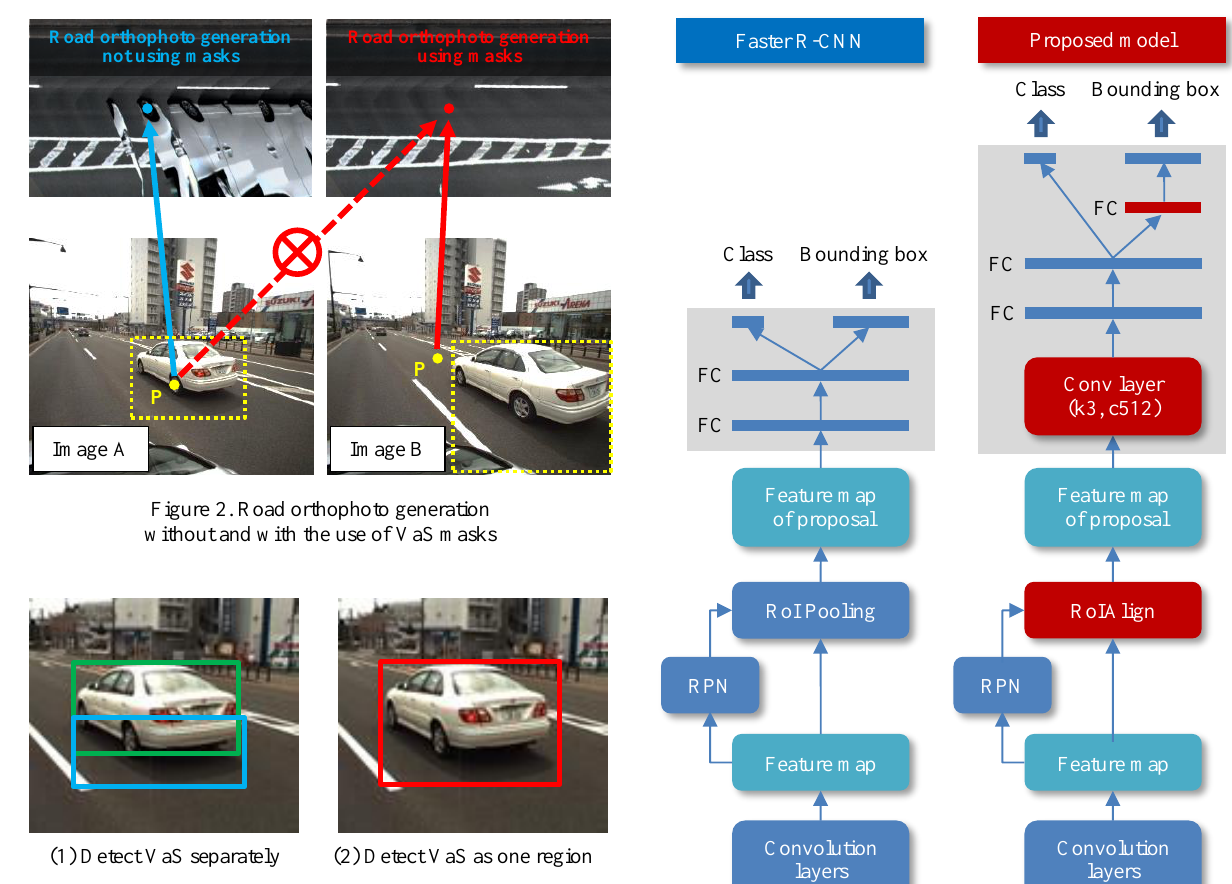
Figure 3. Two available methods for detecting VaS